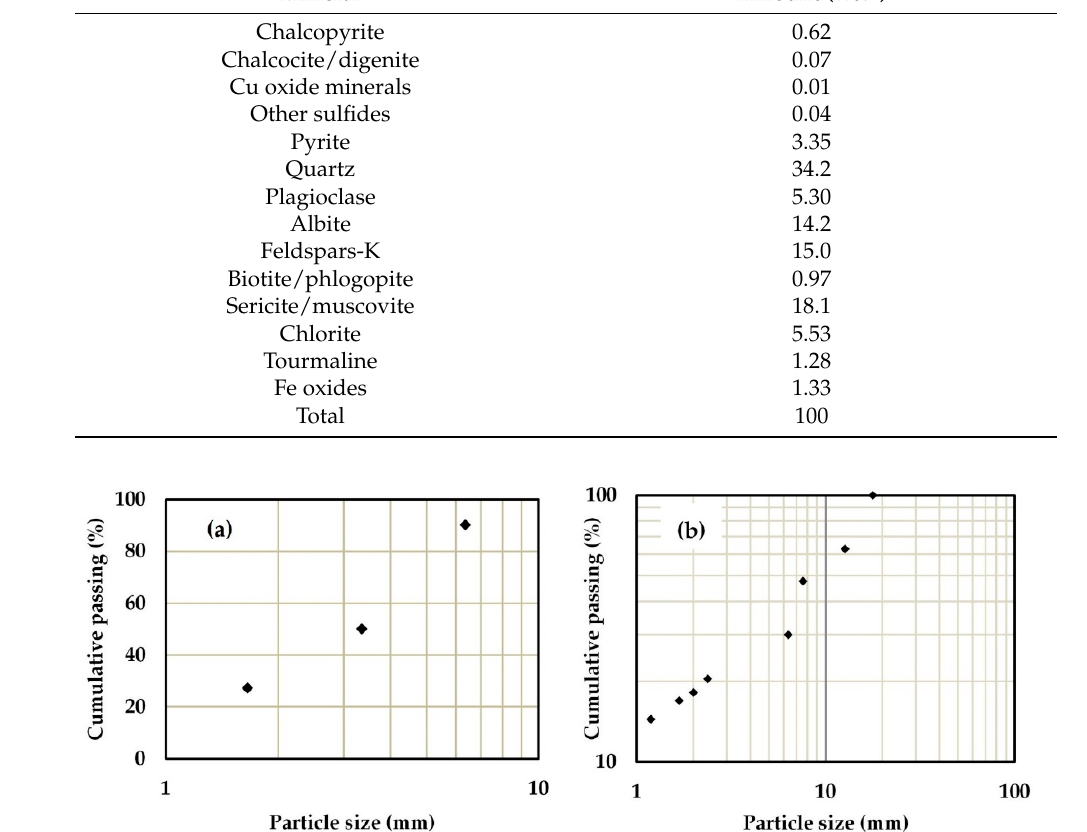
Figure 2. Particle size distribution of the chalcopyrite ore used in the column leaching tests. ( a ) columns 0.45 m high and ( b ) columns 1 m high.